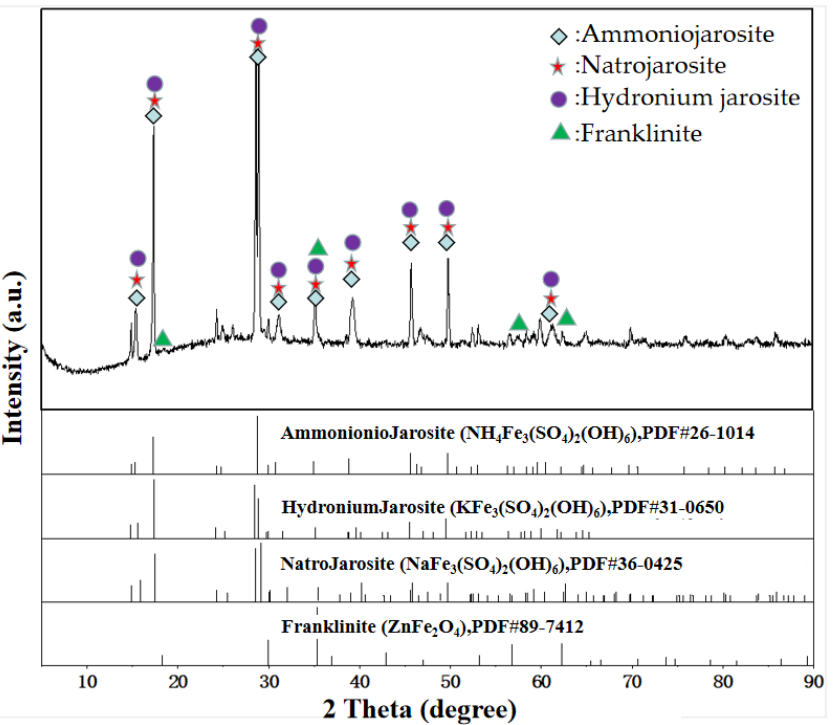
Figure 1. XRD of jarosite residue.